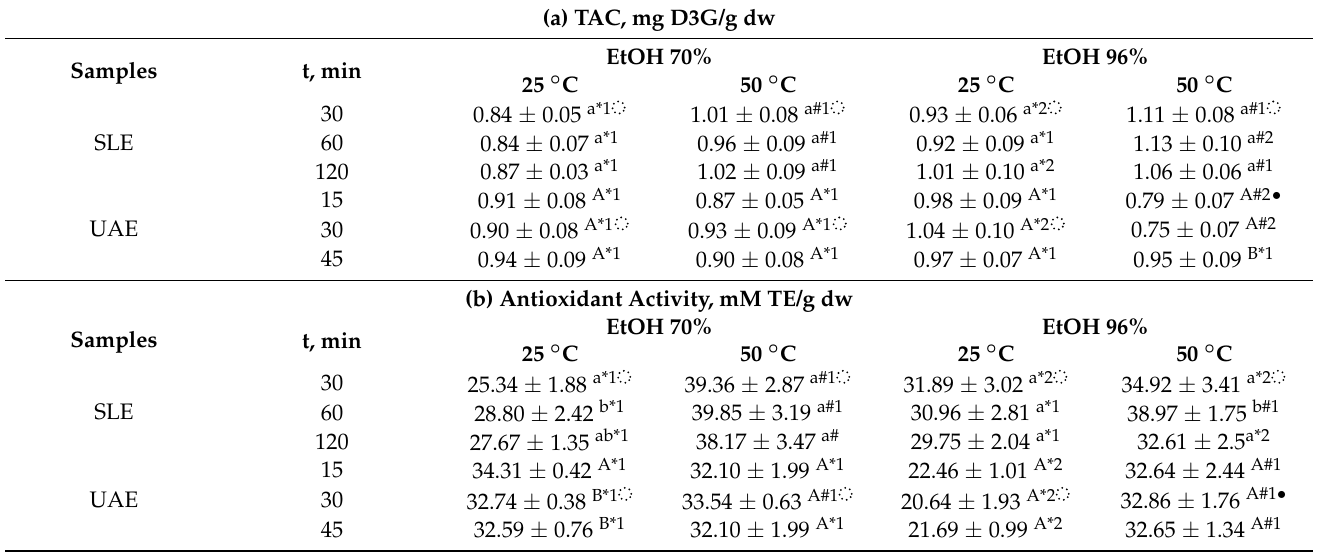
The influence of extraction time was highlighted using lowercase and uppercase letters for SLE and UAE, respectively, in a column. The influence of extraction temperature and solvent concentration was highlighted using symbols ( * , # ) and digits, respectively, in lines. The differences between the extraction methods were highlighted using symbols ( , • ) in a column. Values that share a letter/symbol/digit are not significantly different ( p > 0.05). TAC = total anthocyanin content; EtOH = ethanol; t = time; D3G = delphinidin 3- O -glucoside; TE = Trolox Equivalent; dw = dry